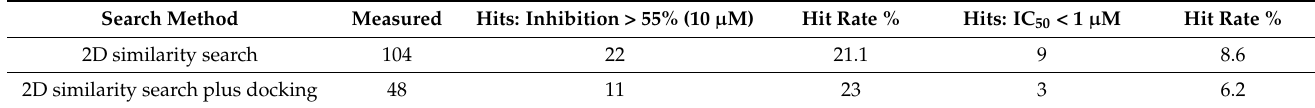
Table 6. Comparison of the 2D similarity search and the parallel integrated